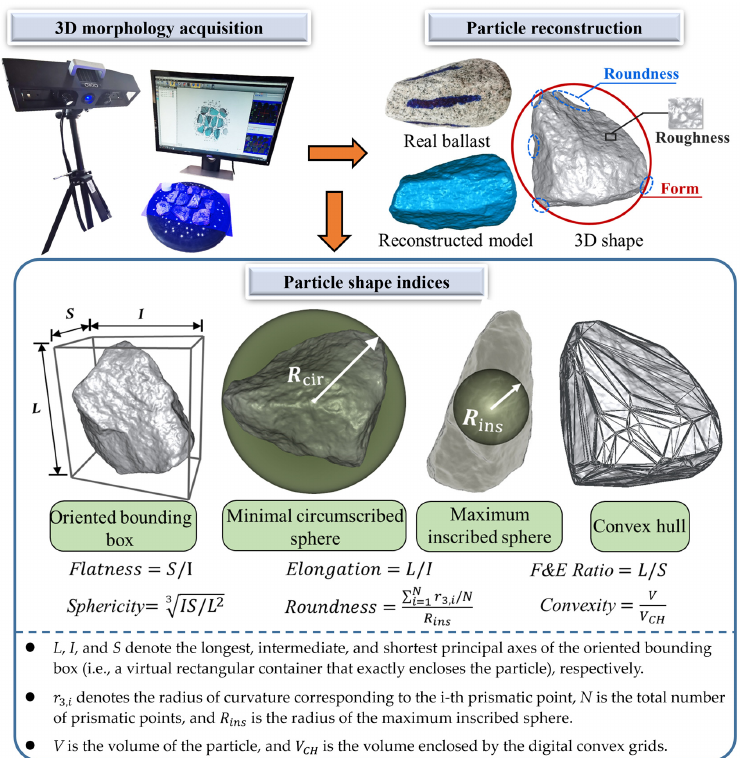
Figure 3. Illustration of reconstructing digital 3D models of selected ballast particles and calculating their shape indices.